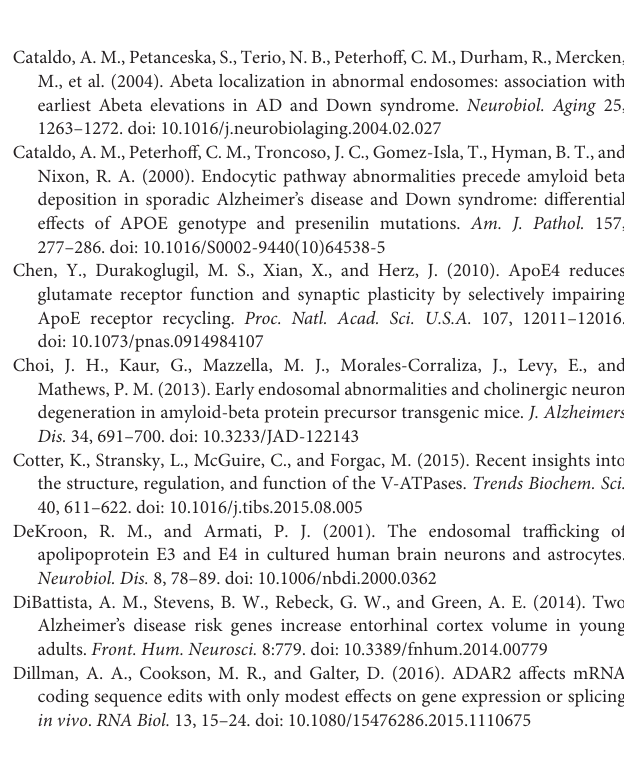
Table S1 | Differentially expressed genes from the EC of APOE3/4 vs. APOE3/3 mice. Table S2 | Differentially expressed genes from the PVC of APOE3/4 vs. APOE3/3